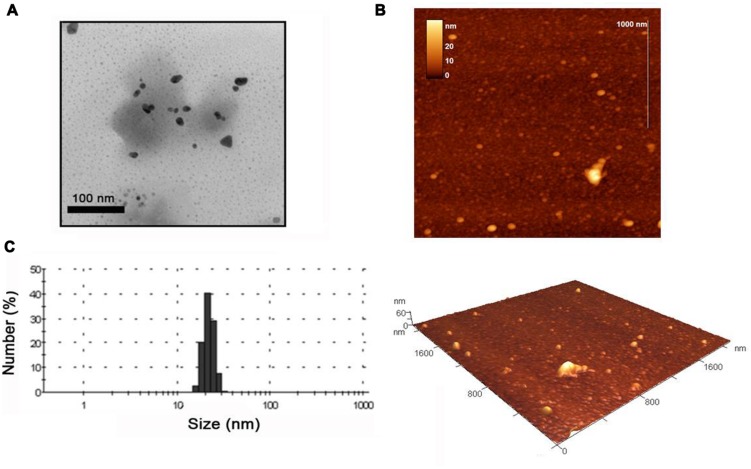
Transmission electron microscope images of (A) gold nanoparticles produced using MBP TMV and 3 mM potassium tetrachloroaurate. Scale bars are shown. (B) AFM images of the formed gold nanoparticles with appropriate scales. (C) DLS data showing size distribution of gold nanoparticles.